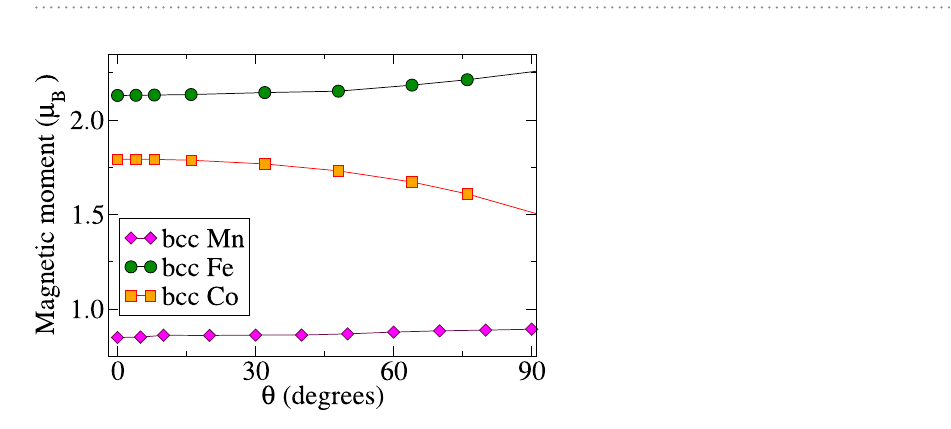
Figure 7. Relative change of the J 1 coupling in bcc Mn (top panel) and bcc Co (bottom panel) as a function of the rotation angle θ of an individual magnetic moment in the FM environment. Each symmetry-resolved component is renormalised separately.